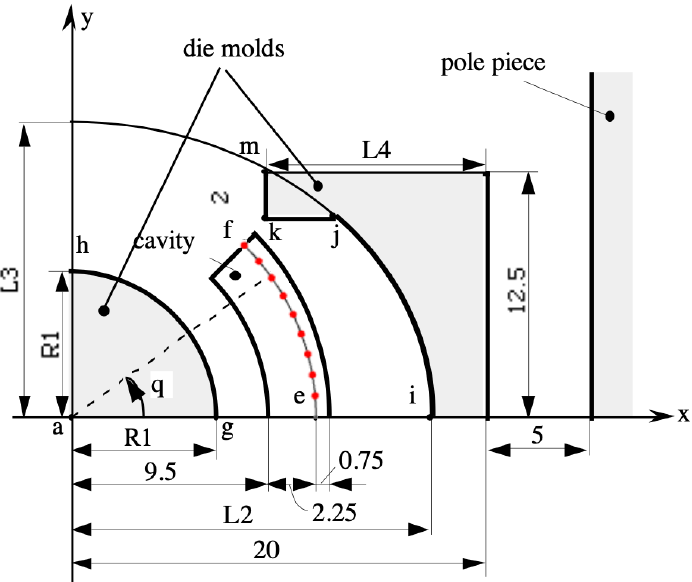
Figure 4. Geometry of the mold for the TEAM 25 problem—measures are in